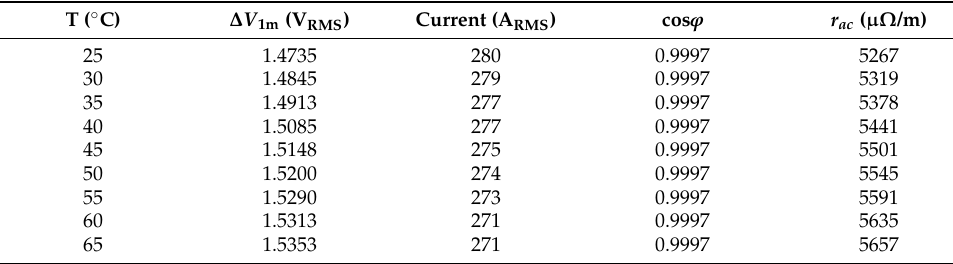
Table 5. Dependence of r ac with the temperature of the tubular